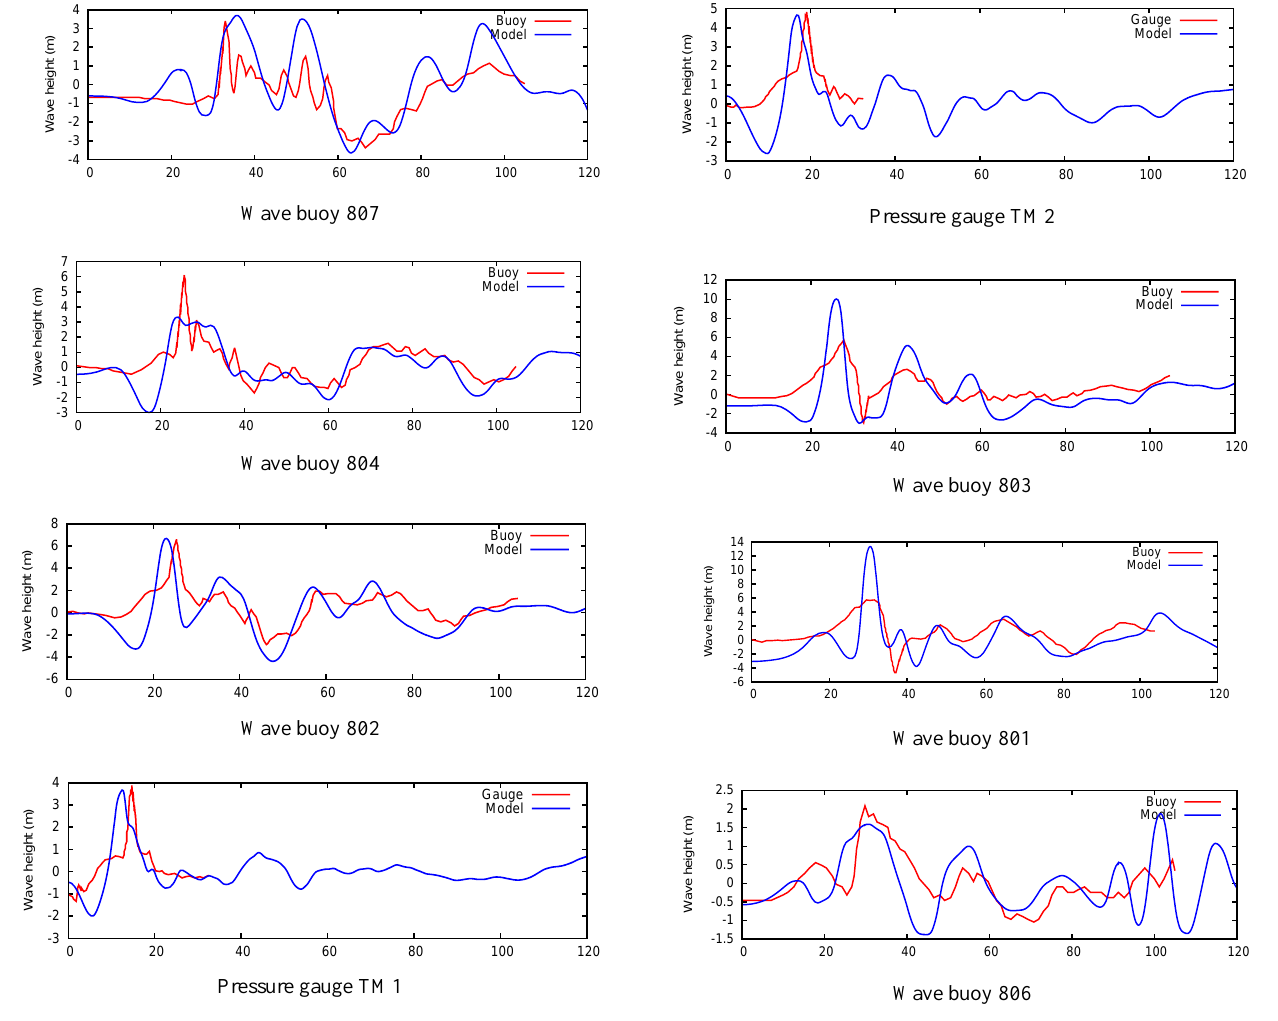
Fig. 18. Comparison between recorded and modelled wave ampli- tudes for the inshore locations indicated in Fig. 5 (continued). The stations are ordered by latitude from top to bottom. The horizontal axis is time in